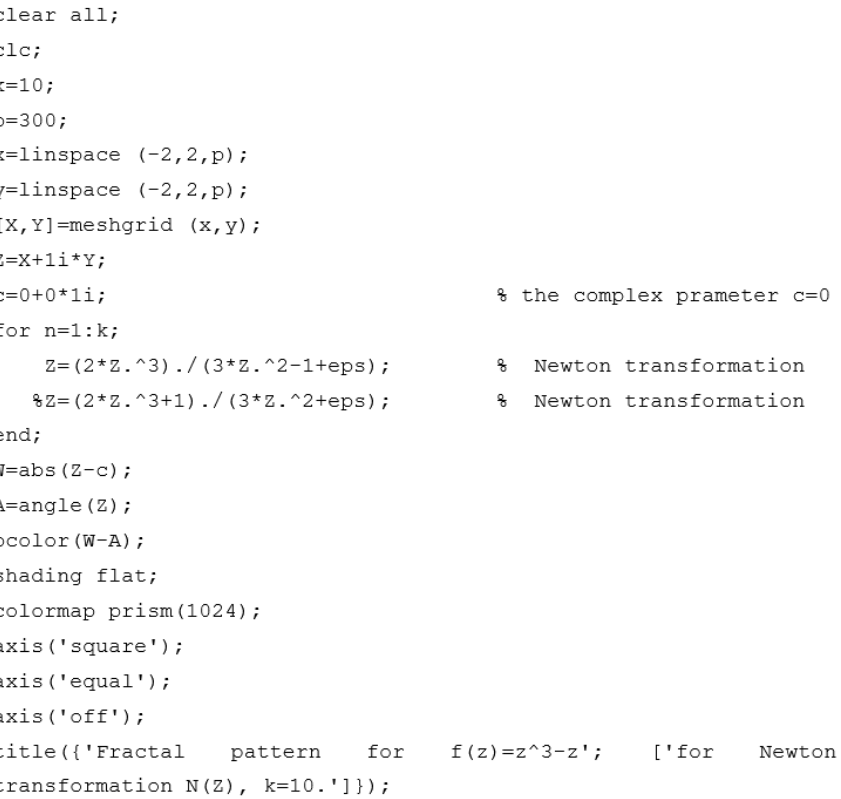
Figure A1. MATLAB program for generating the fractal pattern of Newton-Raphson method